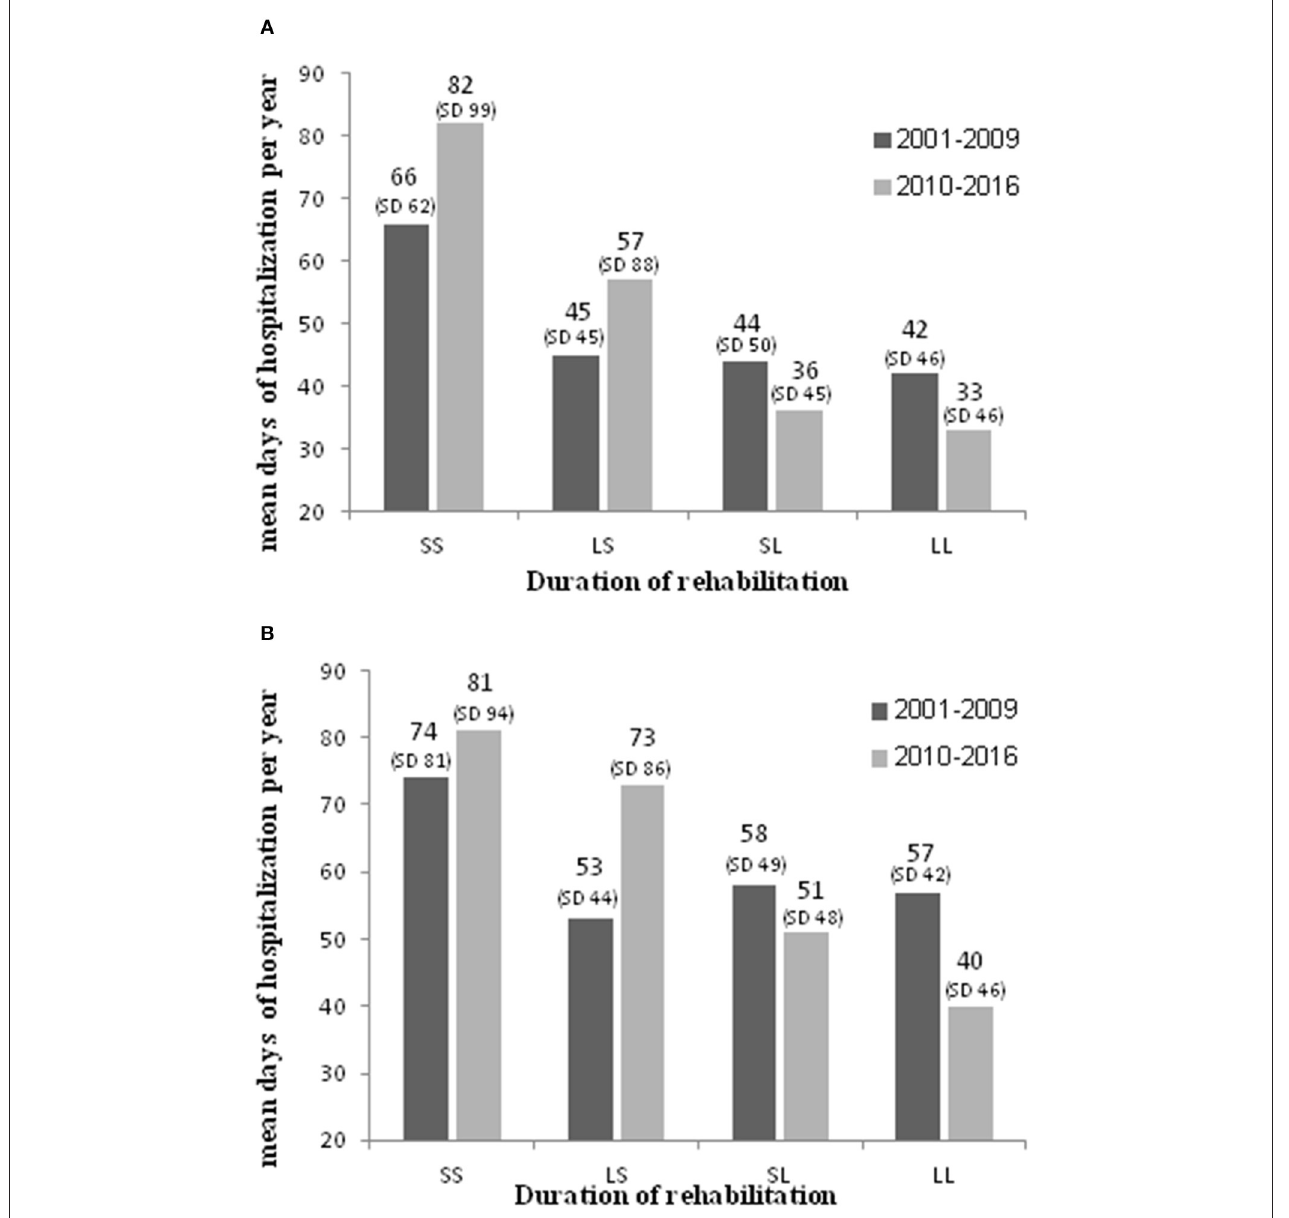
FIGURE 3 | Mean psychiatric hospitalization days per year, by duration of housing rehabilitation in Period 1 (2001–2009) and Period 2 (2010–2016), among hospitalized persons with chronic psychotic disorder without co-occurring SUD (A) and with SUD (B) who received any housing rehabilitation, Israel, 2010–2016. (A) Hospitalized persons with chronic psychotic disorder without SUD. (B) Hospitalized persons with chronic psychotic disorder with SUD. SS, short rehabilitation in Period 1 and Period 2 ; LS, long rehabilitation in Period 1 & short in Period 2 ; SL, short rehabilitation in Period 1 & long in Period 2 ; LL, long rehabilitation in Period 1 and Period 2